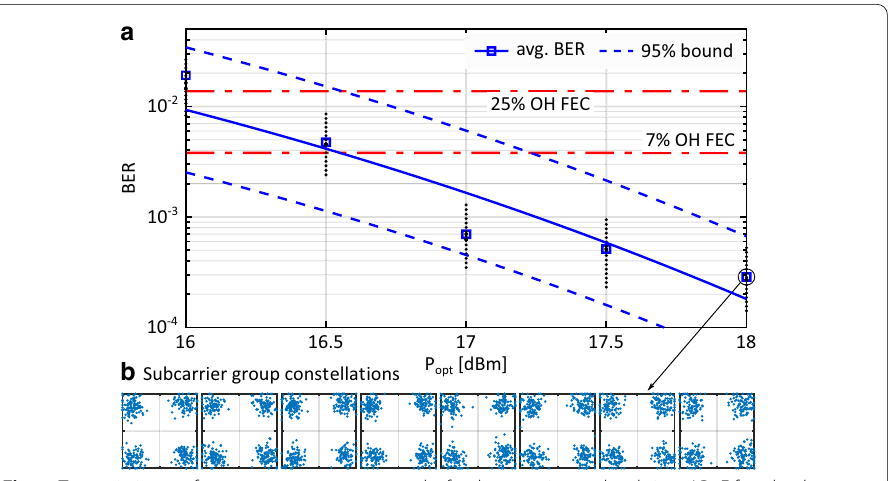
Fig. 7 Transmission perfromance measurement results for the experimental real-time ARoF fronthaul demonstration: a real-time BER in dependence of optical power after two-tone generation and associated statistics, b observed constellations for the 800 MHz wide 5G NR OFDM signal. BER: bit error rate, OH: overhead, FEC: forward error